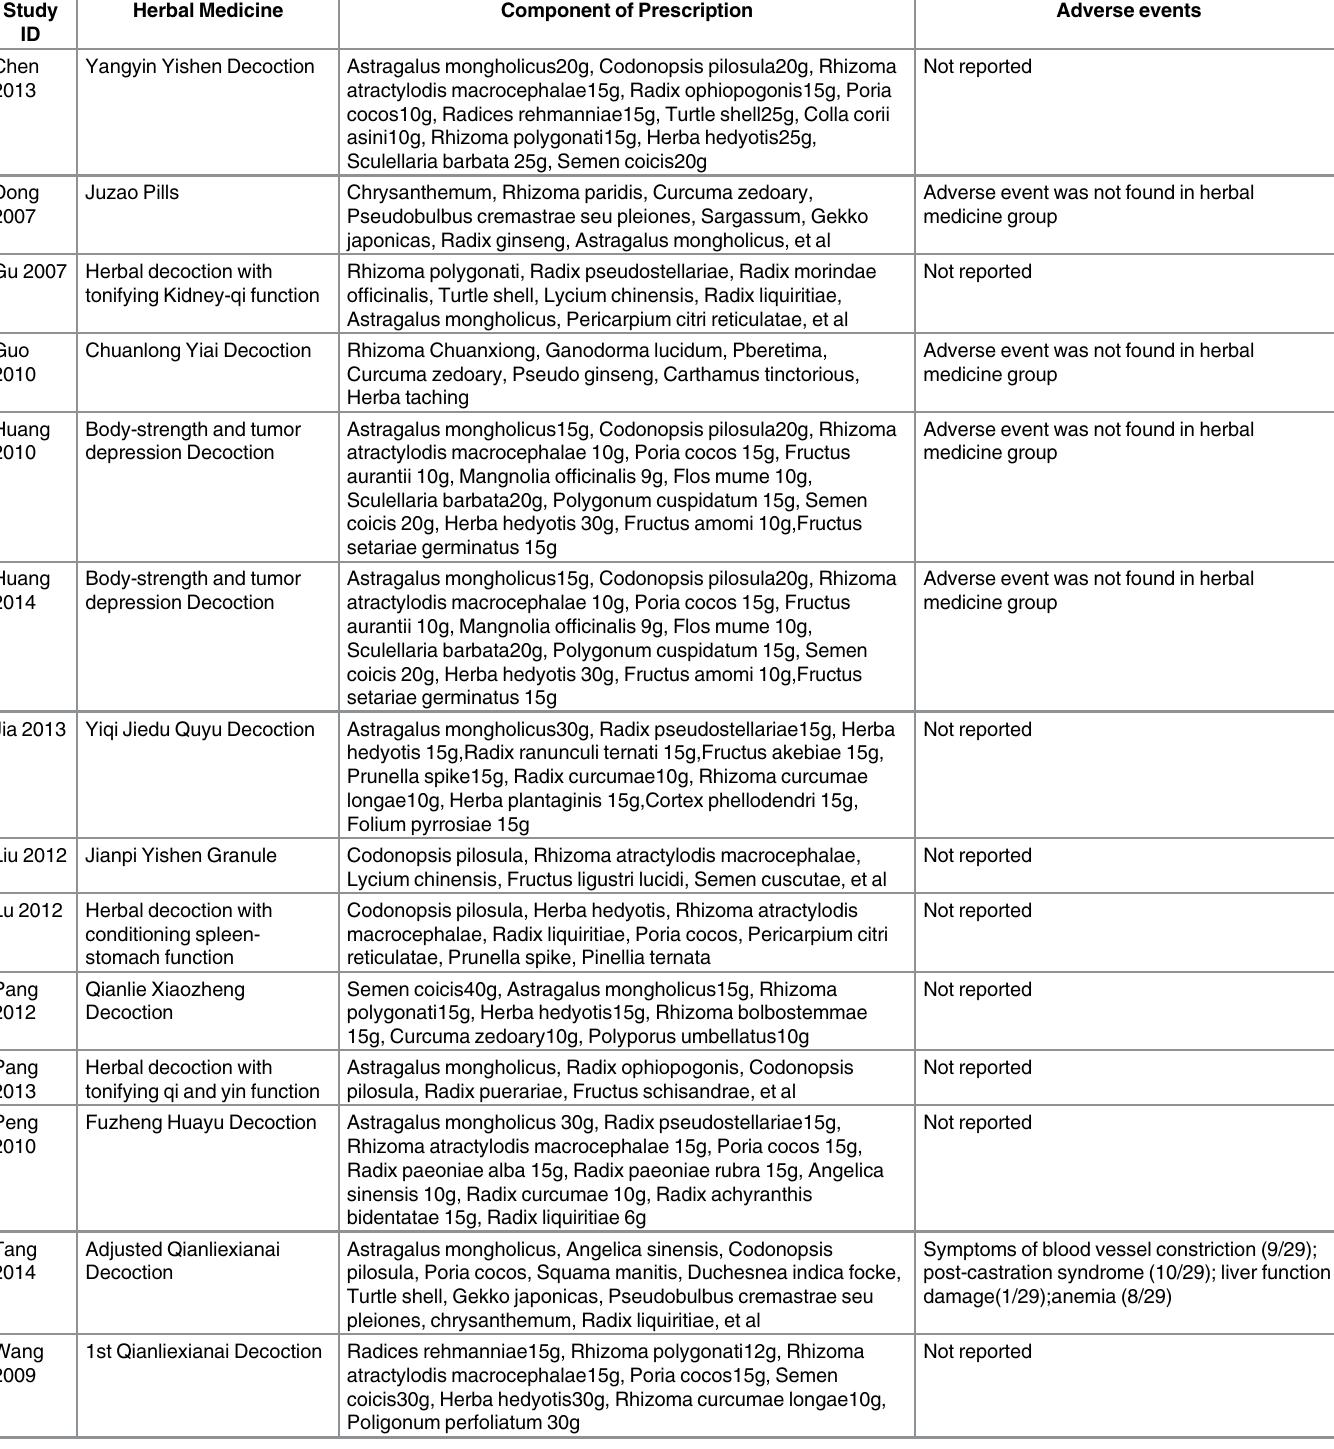
Table 2. Components and adverse events of herbal prescriptions in 17 included